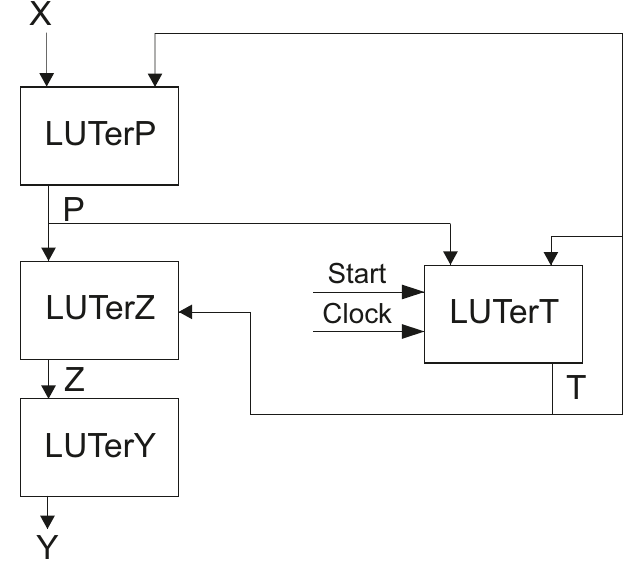
Figure 4. Structural diagram of Mealy FSM U 4